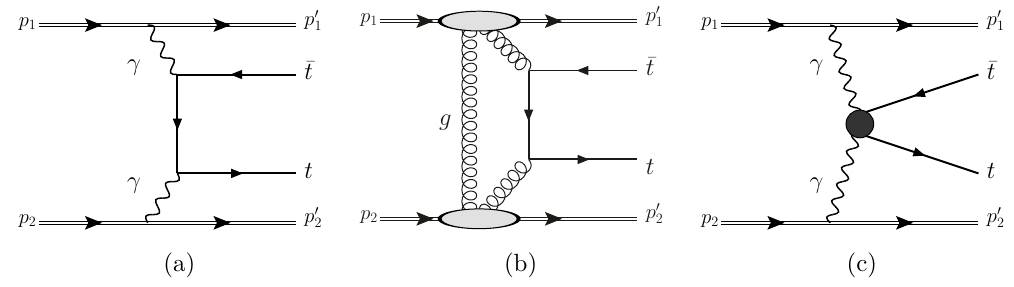
Figure 1. Feynman diagram for exclusive production of t ¯ t via photon fusion (a), color-singlet two-gluon fusion (b), and anomalous exclusive production via a local effective operator from the basis (2.1)